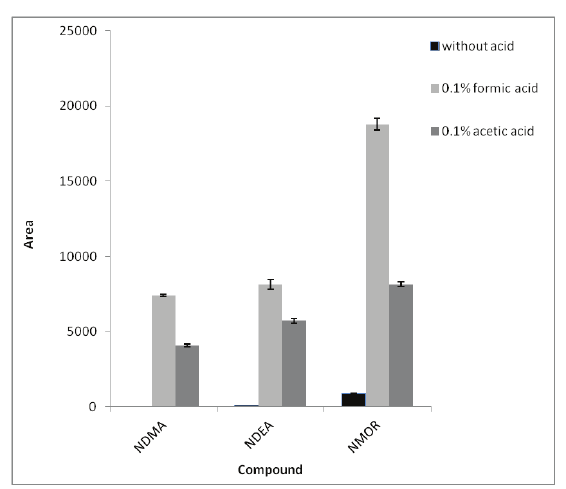
Figure 2. Influence of the presence of acetic acid and formic acid in mobile phase (acetonitrile/ultrapure water (60:40, v/v)). This mobile phase was modified with 0.1% formic acid and acetic acid in water